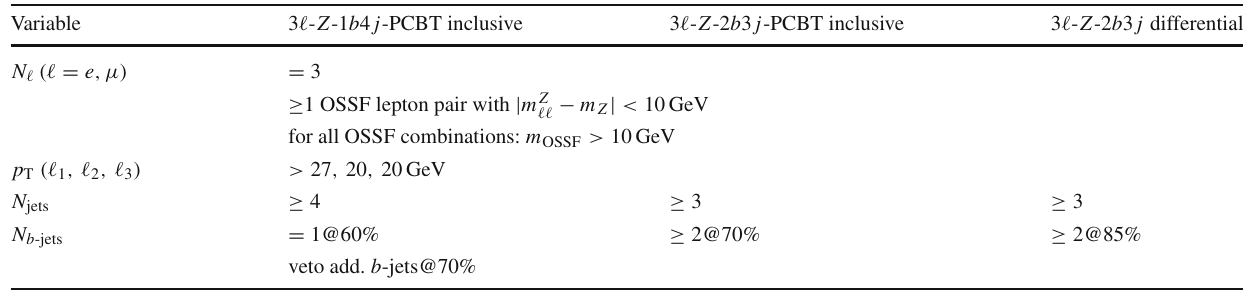
the differential measurement only the region 3 (cid:11) - Z -2 b 3 j with a fixed b -tagging WP is employed